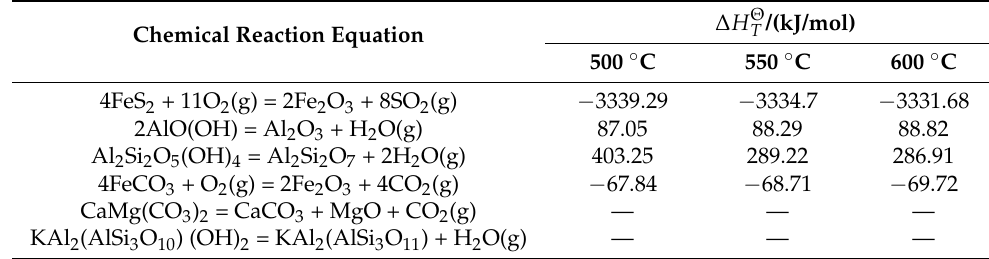
Table 3. Reactions and heat of reaction of high-sulfur bauxite during the roasting